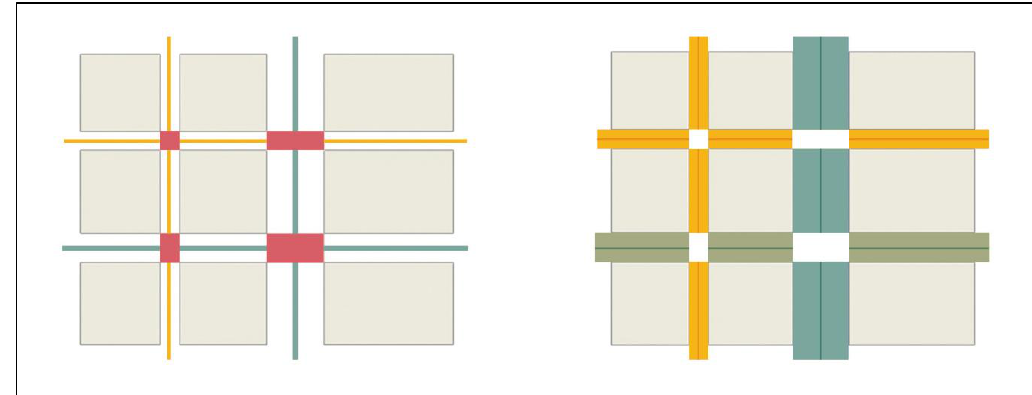
Figure 17. ( Left ) Example of design parameters for courtyard buildings. ( Right ) Available typologies for (new) buildings.